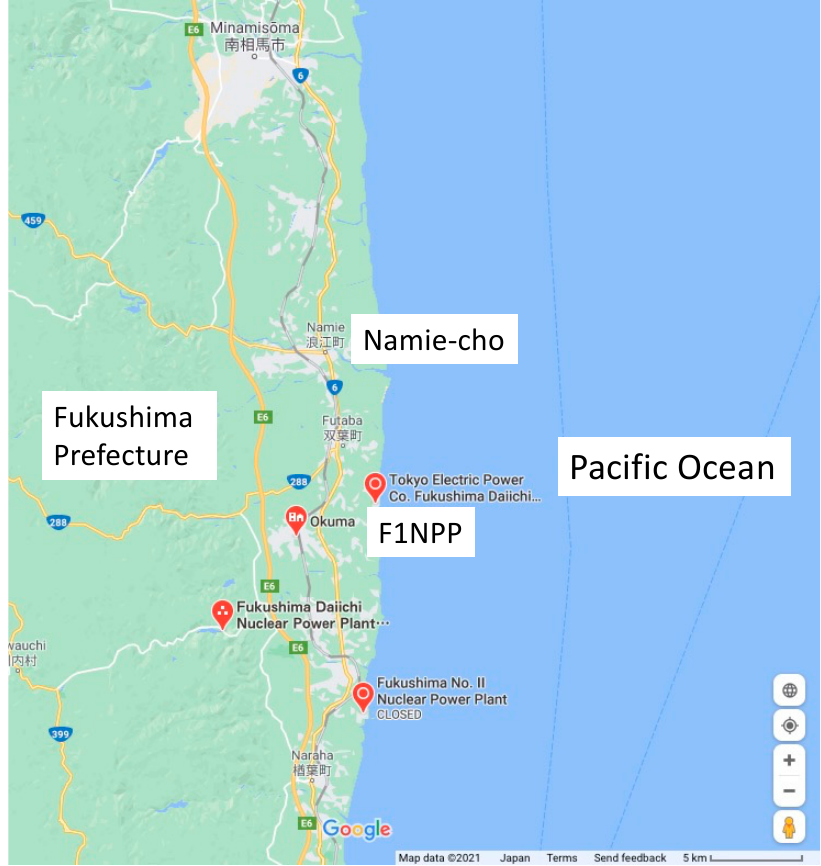
Figure 1. Map of sampling site (Namie-cho) and Fukushima Dai-ichi Nuclear Power Plant (F1NPP) in Fukushima, Japan (from Google map) with a map of the FINPP disaster. Original map was downloaded from Google map.